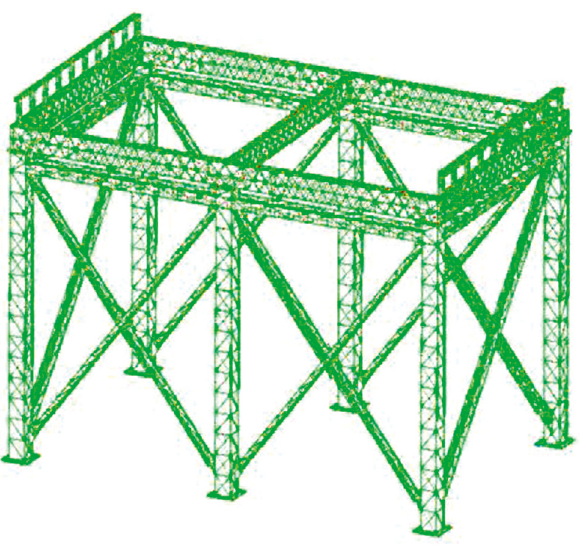
Figure 13: The finite element model of the bottom beam and bracket.